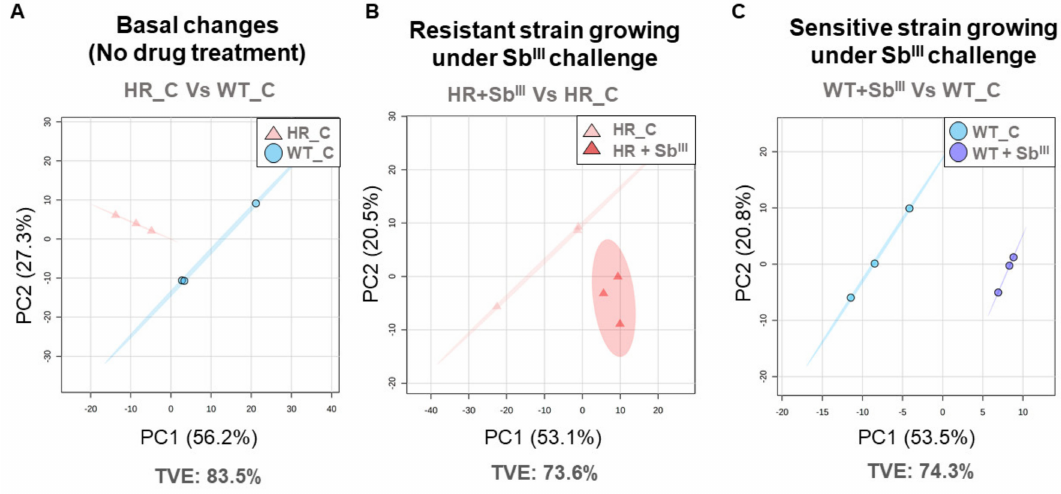
Figure 8. Unsupervised multivariate analysis showing a clear sample grouping per class. The PCA score plots are represented by individual comparison. The data from three biological repeats were analyzed. ( A ) PCA score plot of the basal antimony resistant phenotype changes explaining 83.5% of the total variance. ( B ) PCA score plot of the resistant strain responding to Sb III , explaining 73.6% of the total variance. ( C ) PCA score plot of the sensitive strain responding to Sb III , explaining 74.3% of the total variance. Each individual marker represents a biological replicate. Total variance explained (TVE) in summarized. The 95% confidence ellipse using Hotelling T-squared is